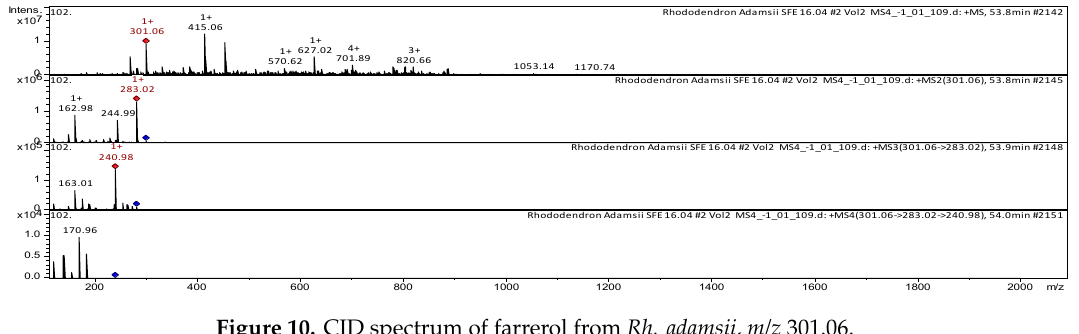
Figure 10. CID spectrum of farrerol from Rh. adamsii , m / z 301.06.